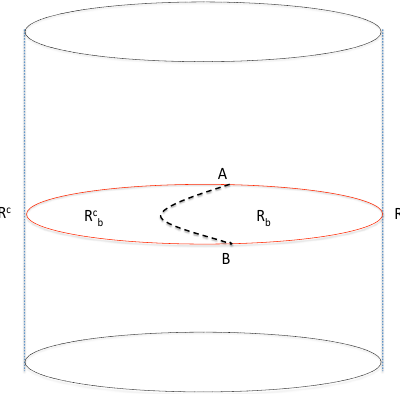
Figure 1 . At the boundary CFT d of the global AdS d +1 cylinder, we have a disc shaped region R denoted by AB (red line, color online). The dashed (black) line (cid:13) represents the RT surface which divides the bulk region into two subregions R b and R c . The area of this minimal surface gives the b leading semiclassical term of the total boundary entanglement entropy S EE . The O ( G 0 ) term of bulk entanglement entropy of the region R b is a measure of the (cid:12)rst-order quantum correction term S EE ;q of S EE